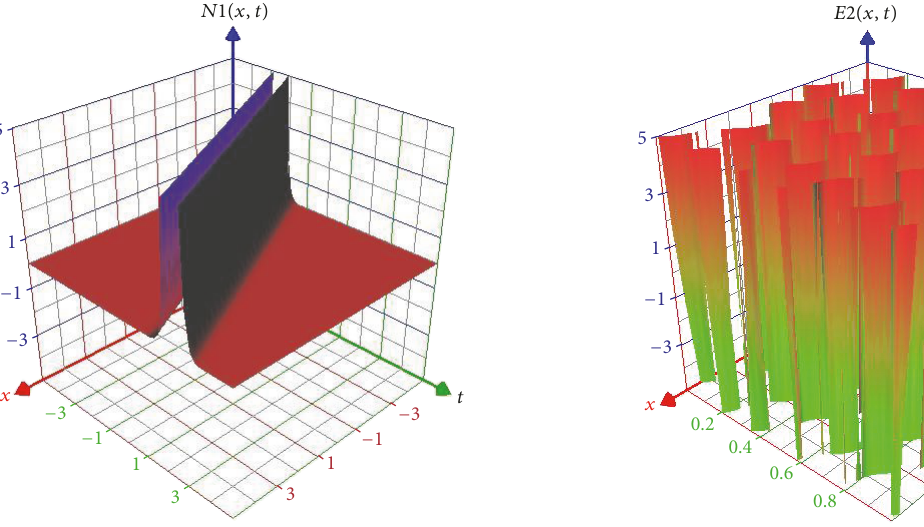
Figure 2: The solitary wave 𝑁 1 (𝑥,𝑡) in (24) for −5 ≤ 𝑥 ≤ 5 , 0 ≤ 𝑡 ≤ 1 .